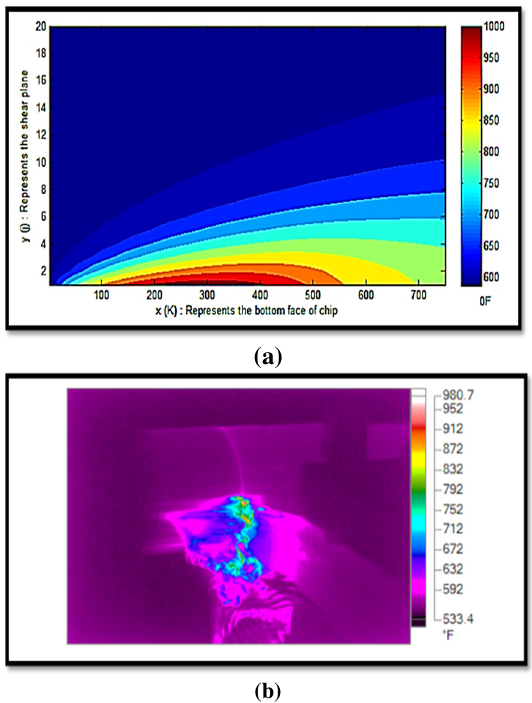
Fig.17.Temperature fields of machining with spindle speed (400 r.p.m), feed (0.18 mm/rev), depth (0.5 mm), (a) temperature distribution simulation, (b) experimental measuring of temperature using IR-Camera.